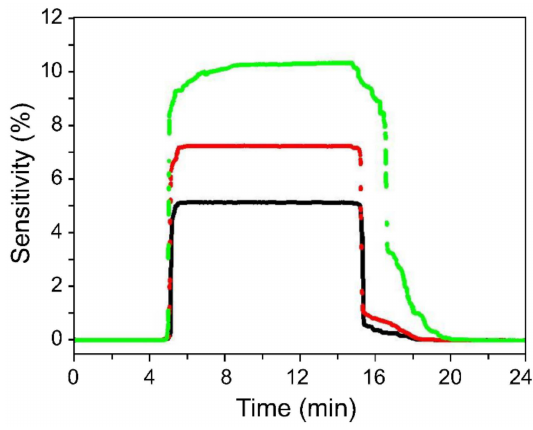
Figure 6. Sensor sensitivity of as function Pd NP size. Sensor response and recovery rates improved with decreasing NP size. The black, red, and green response curves were produced with < 10 nm, < 25 nm, and < 60 nm Pd NPs,